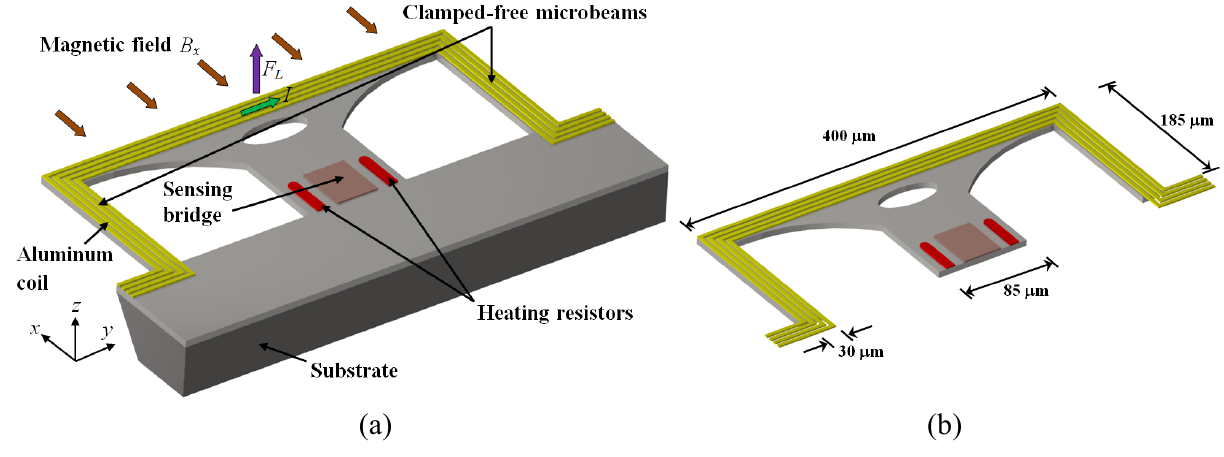
Figure 6. (a) Schematic view of the operation principle and (b) estimate dimensions of the resonant magnetic field sensor developed by Sunier et al .